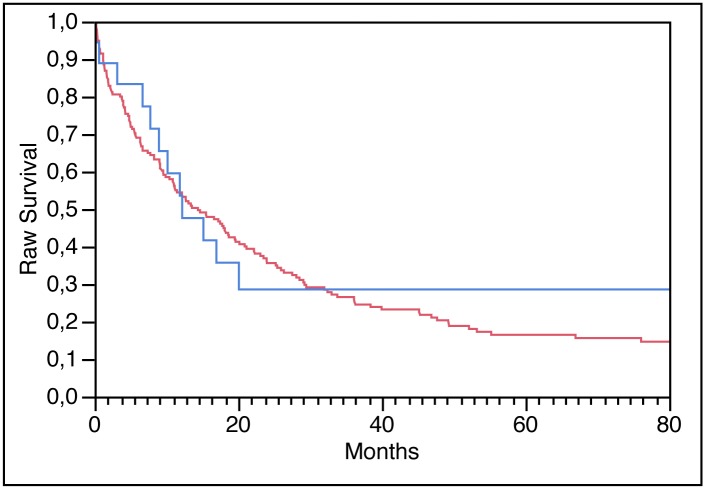
Raw Survival of ESCC patients.Red line: no FGFR1 amplified tumor patients. Blue line: FGFR1 amplified tumor patients.